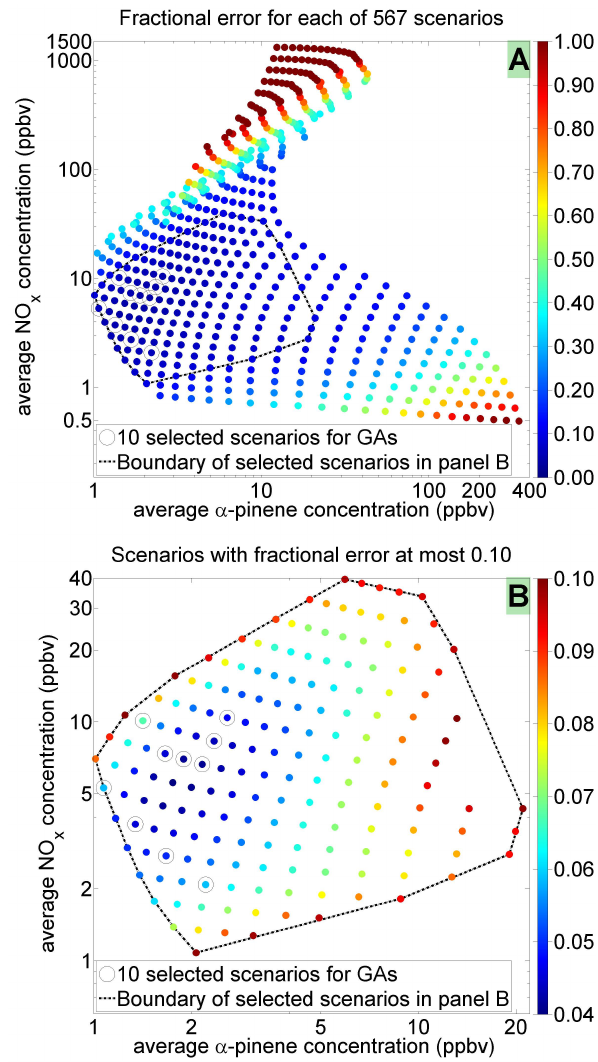
Fig. 7. (A) Errors for each of 567 scenarios under a wide range of conditions. The 10 randomly selected ambient scenarios are used in the GAs to derive a best set of parameters for the SUVS; (B) a total of 175 scenarios are identified with the fractional error at most 0.10. Note that color scales for the fractional errors differ between the two panels, and the smaller numbers (more blue colors) correspond to more accurate